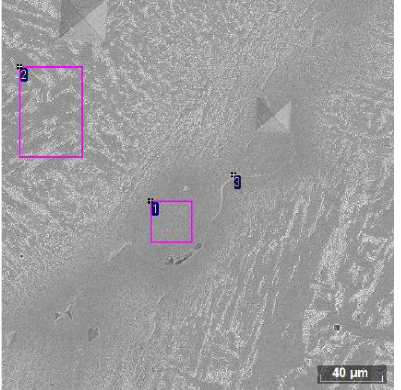
Figure 8. Microstructure in the segregation in CCB.